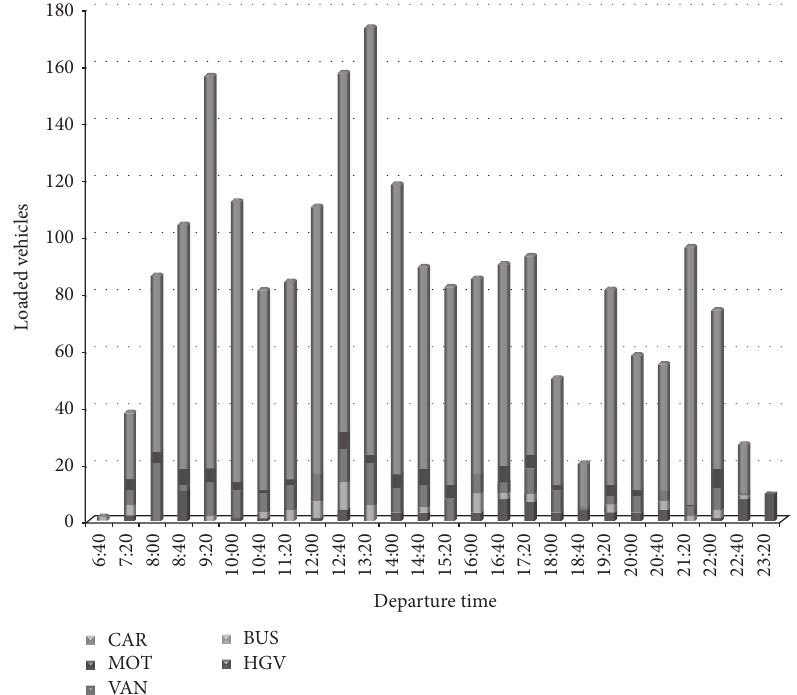
Figure 9: Vehicles embarking on any run of the ferry, first simulation.